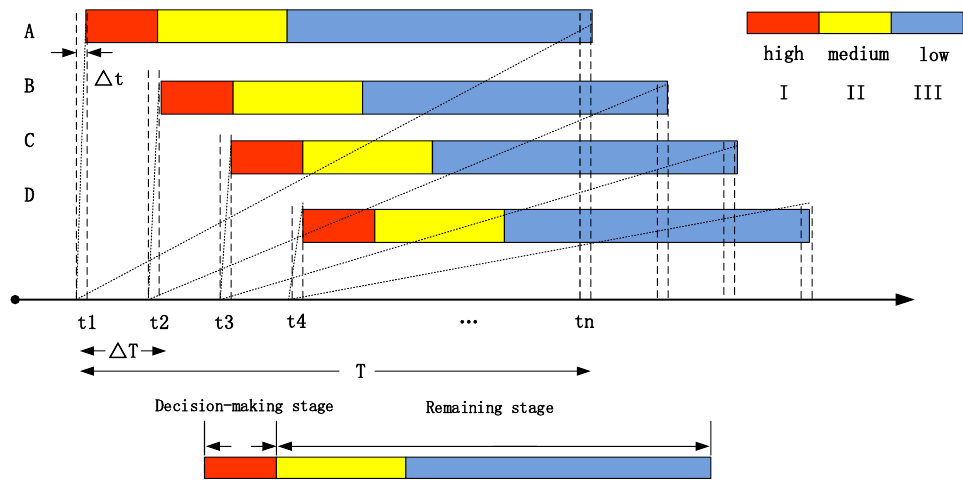
Figure 3. Rolling updating mechanism of the hydropower and photovoltaic combined generation scheduling model.